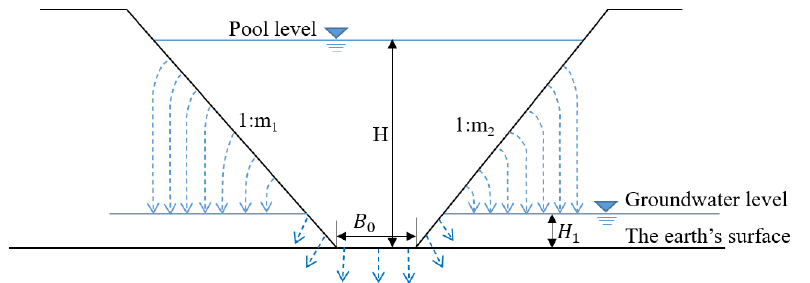
Figure 10. Groundwater level above the bottom of the reservoir.